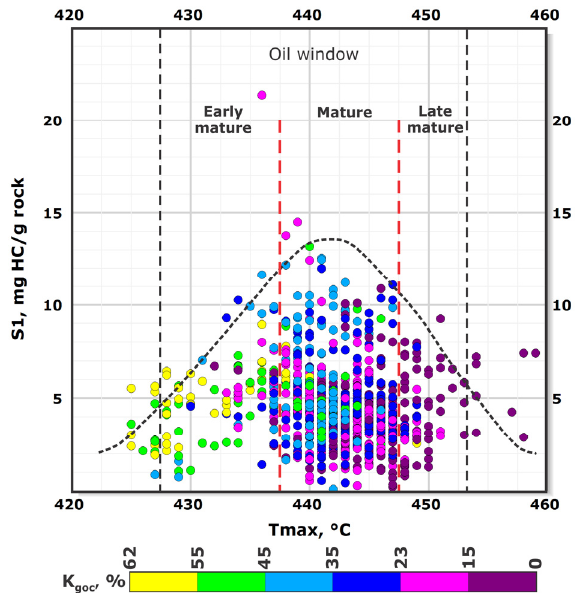
Figure 6. Cross-plot of the amount of generated hydrocarbon fluid (S1) and temperature Tmax illustrating the relations between maturity and fluid saturation of the rocks. The color indicates the proportion of generative kerogen K goc .